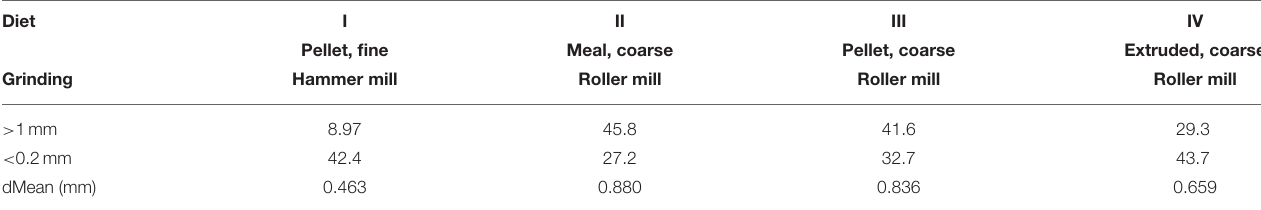
TABLE 1 | Physical forms of the different experimental diets administered to pigs after wet sieving analysis, reporting proportions on DM basis of two sieves with different mesh size ( > 1 and < 0.2mm) and mean particle size (15). Diet I II III IV Pellet, fine Meal, coarse Pellet, coarse Extruded, coarse Grinding Hammer mill Roller mill Roller mill Roller mill > 1mm 8.97 45.8 <